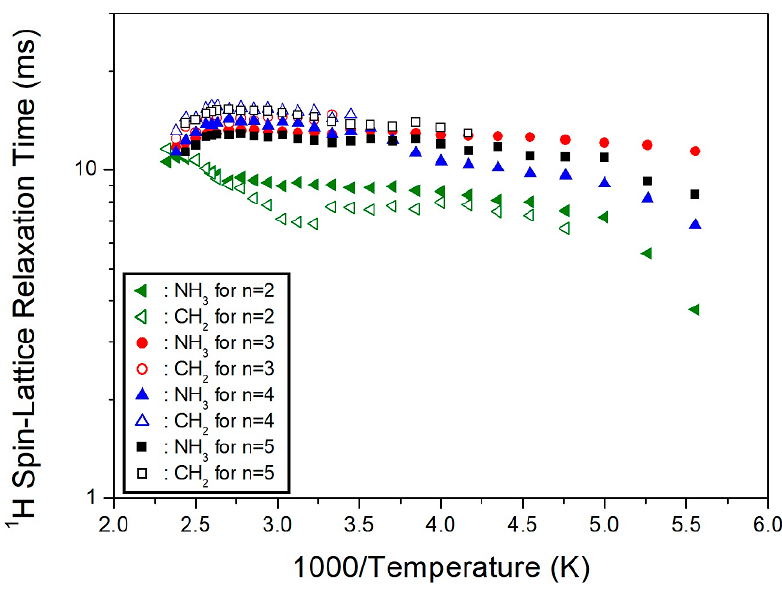
Figure 6. Temperature dependence of 1 H NMR spin-lattice relaxation times (T 1 ρ ) in [NH 3 (CH 2 ) n NH 3 ]CuCl 4 ( n = 2, 3, 4, and 5). The 13 C T 1 ρ values for C1, C2, and C3 were obtained as a function of the inverse temperature from the slope of the logarithm of intensity versus the delay time plot (Figure 7). The 13 C T 1 ρ values increased rapidly from 10–100 ms. The T 1 ρ behavior for random motions, with a correlation time τ C , could be elucidated by a fast motion. The T 1 ρ value of C3, located close to the paramagnetic Cu 2+ ion, was shorter than that of C2, located further away from Cu 2+ . Additionally, the T 1 ρ of C1, at the center of 5 CH 2 , exhibited very short values. It is interesting to compare the results for 13 C T 1 ρ according to the alkyl chain lengths. In the [NH 3 (CH 2 ) n NH 3 ] cation, the marks of C1, C2, and C3 along the length of n are shown in Figure 8. The 13 C T 1 ρ values exhibited similar trends for n =3, 4, and 5, with a very short value for n = 2, as shown in Figure 7. In the case of n = 5, unlike n = 2, 3, and 4, the T 1 ρ value of C2 was different from those of C1 and C3. Overall, energy transfer was easier for the short alkyl chain length ( n = 2).